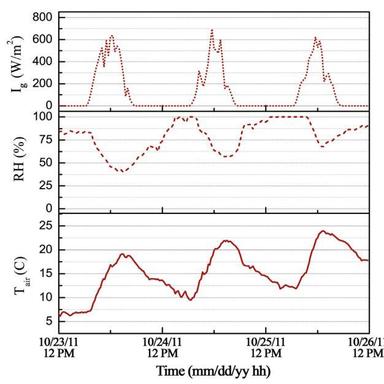
Imposed environmental cycle reproducing the global radiation (Ig ), relative humidity (RH) and air temperature (Tair) conditions of the period October 23–26th 2011.